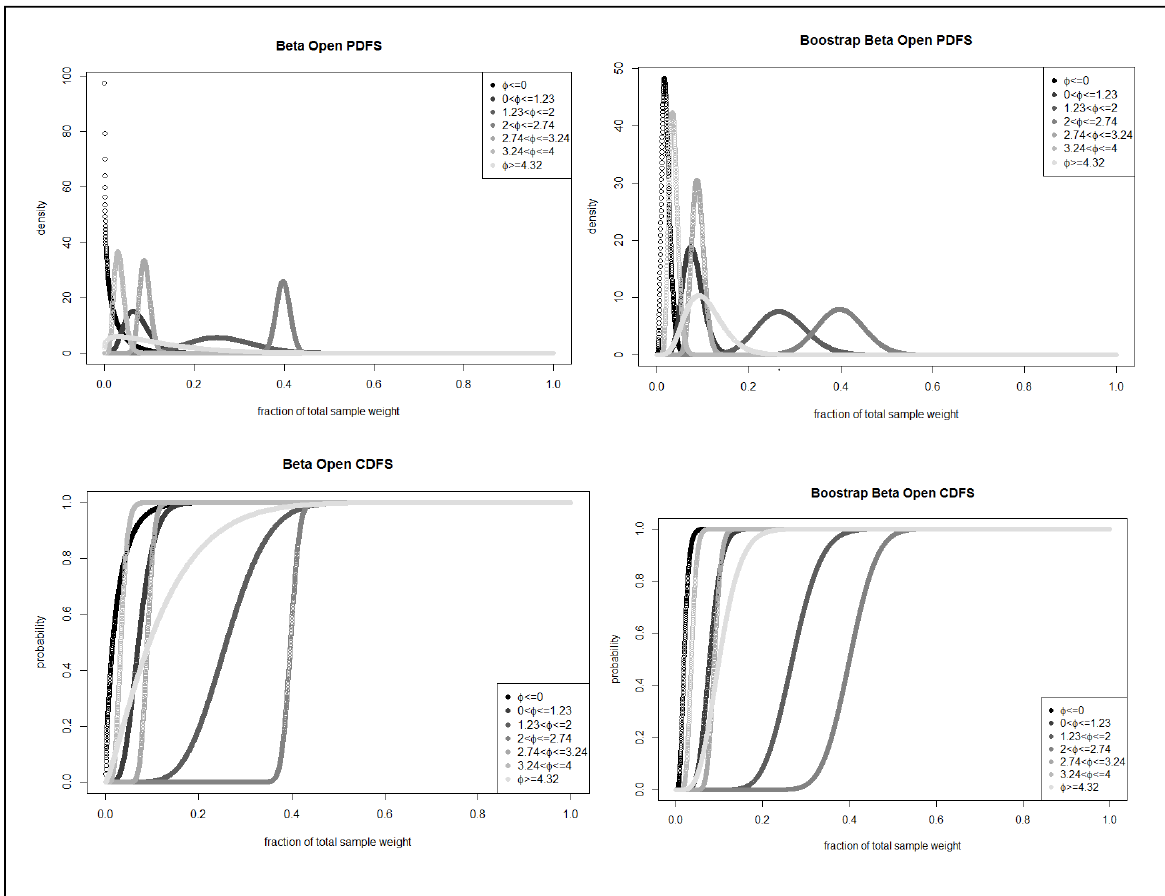
Figure 9. Open design setting—beta distributions of original samples along with bootstrap distributions.